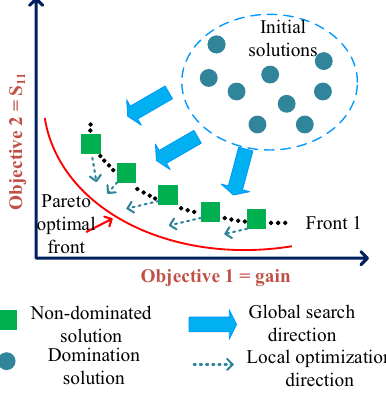
Figure 2. Example of Pareto front in two-objective